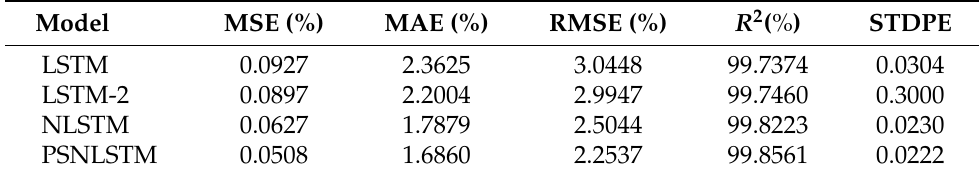
Table 3. The temperature prediction performance of ϑ SY .